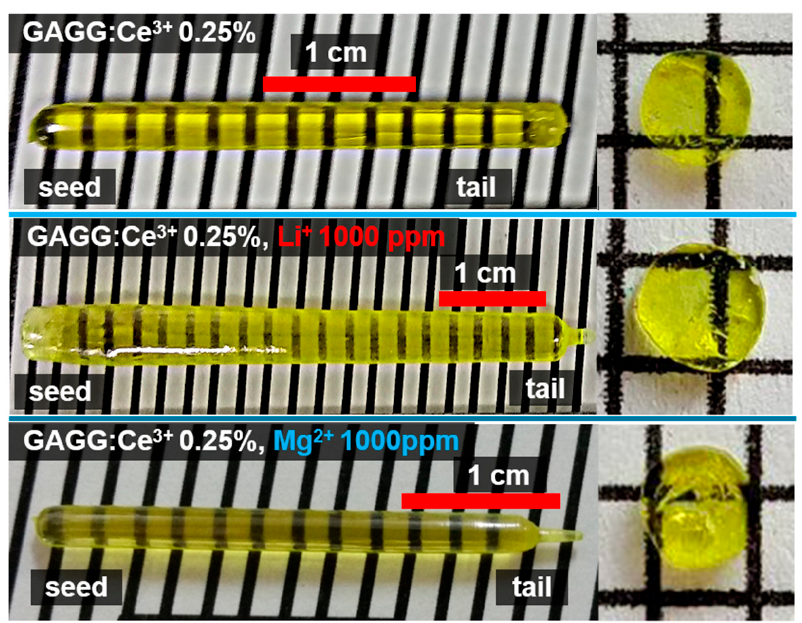
Figure 1. As-grown rods of Li + and Mg 2+ co-doped GAGG:Ce with polished radial plates cut 5 mm away from the seed end of the crystals.